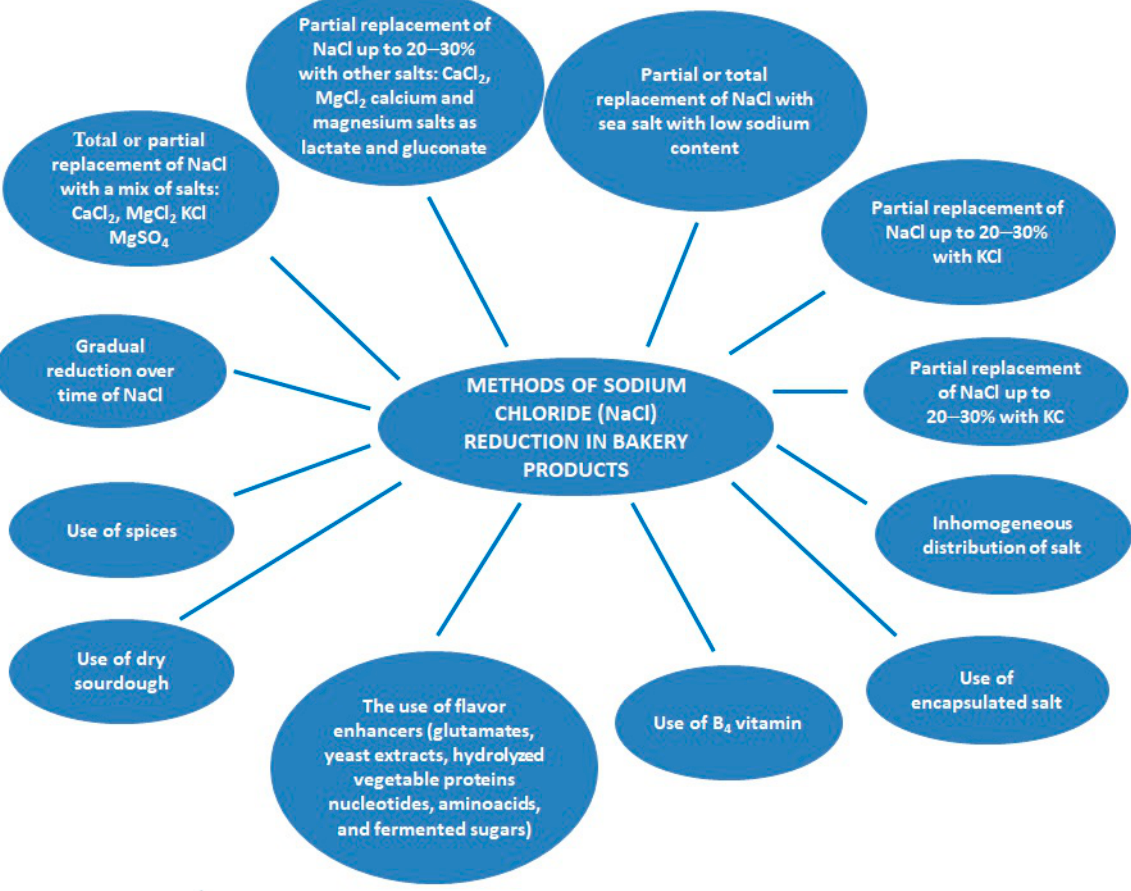
Figure 1. Strategies of salt reduction in bakery products.